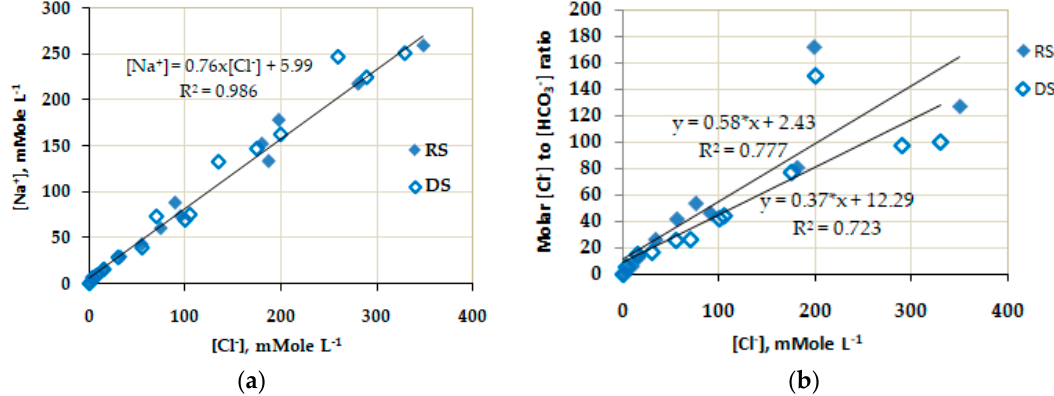
Figure 6. Relationship between molar concentrations of Na + and Cl − ions ( a ), and relationship between molar [Cl − ] to [HCO 3 − ] ratio and [Cl − ] ( b ) for water tapped from Holocene aquifer indicating the influence of seawater to water in the shallow aquifer (the data for constructing graphs ( a , b ) were taken from Table S2).